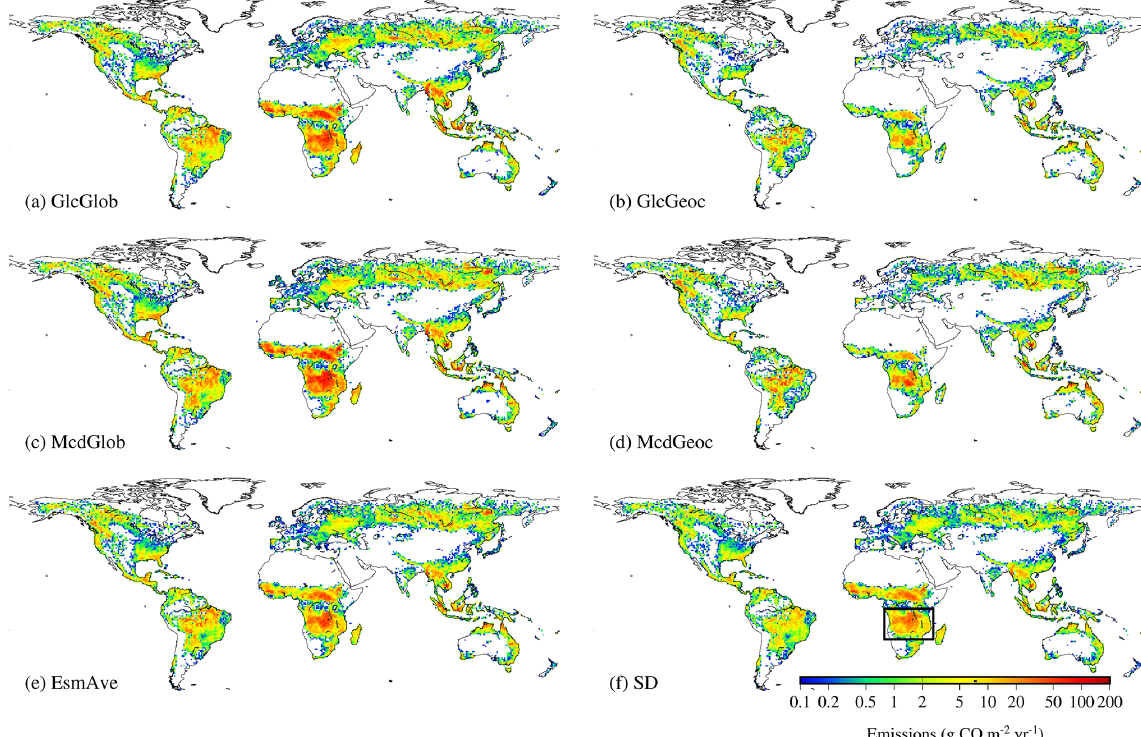
Figure 2. Spatial distributions of the annual average of CO emissions (gCOm − 2 yr − 1 ) for (a) GlcGlob, (b) GlcGeoc, (c) McdGlob, (d) Mcd- Geoc, and (e) EsmAve and (f) their standard deviation based on four BB emissions estimates over the period